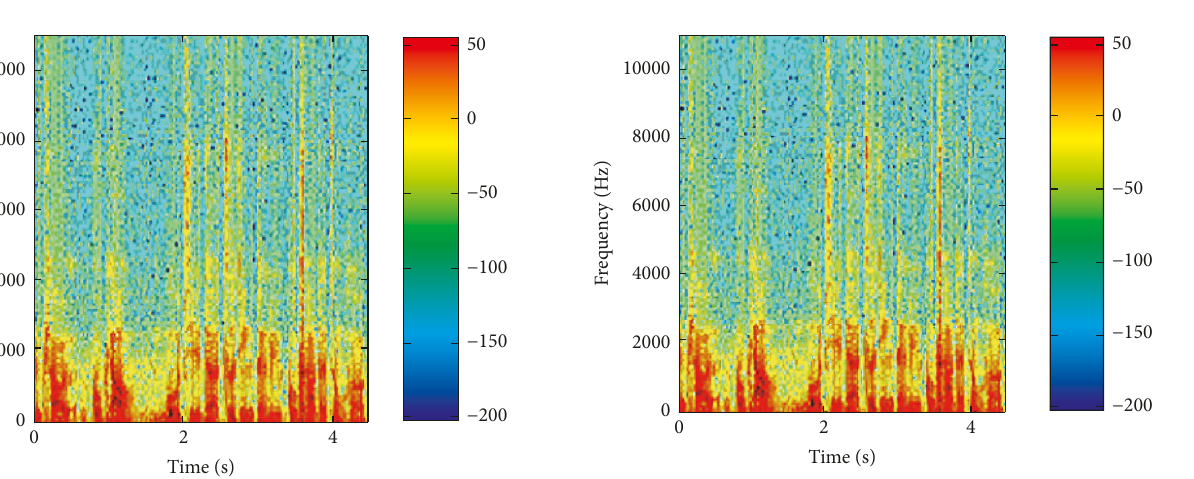
Figure 3: Time domain sequence waveform of the original outlier data information flows.